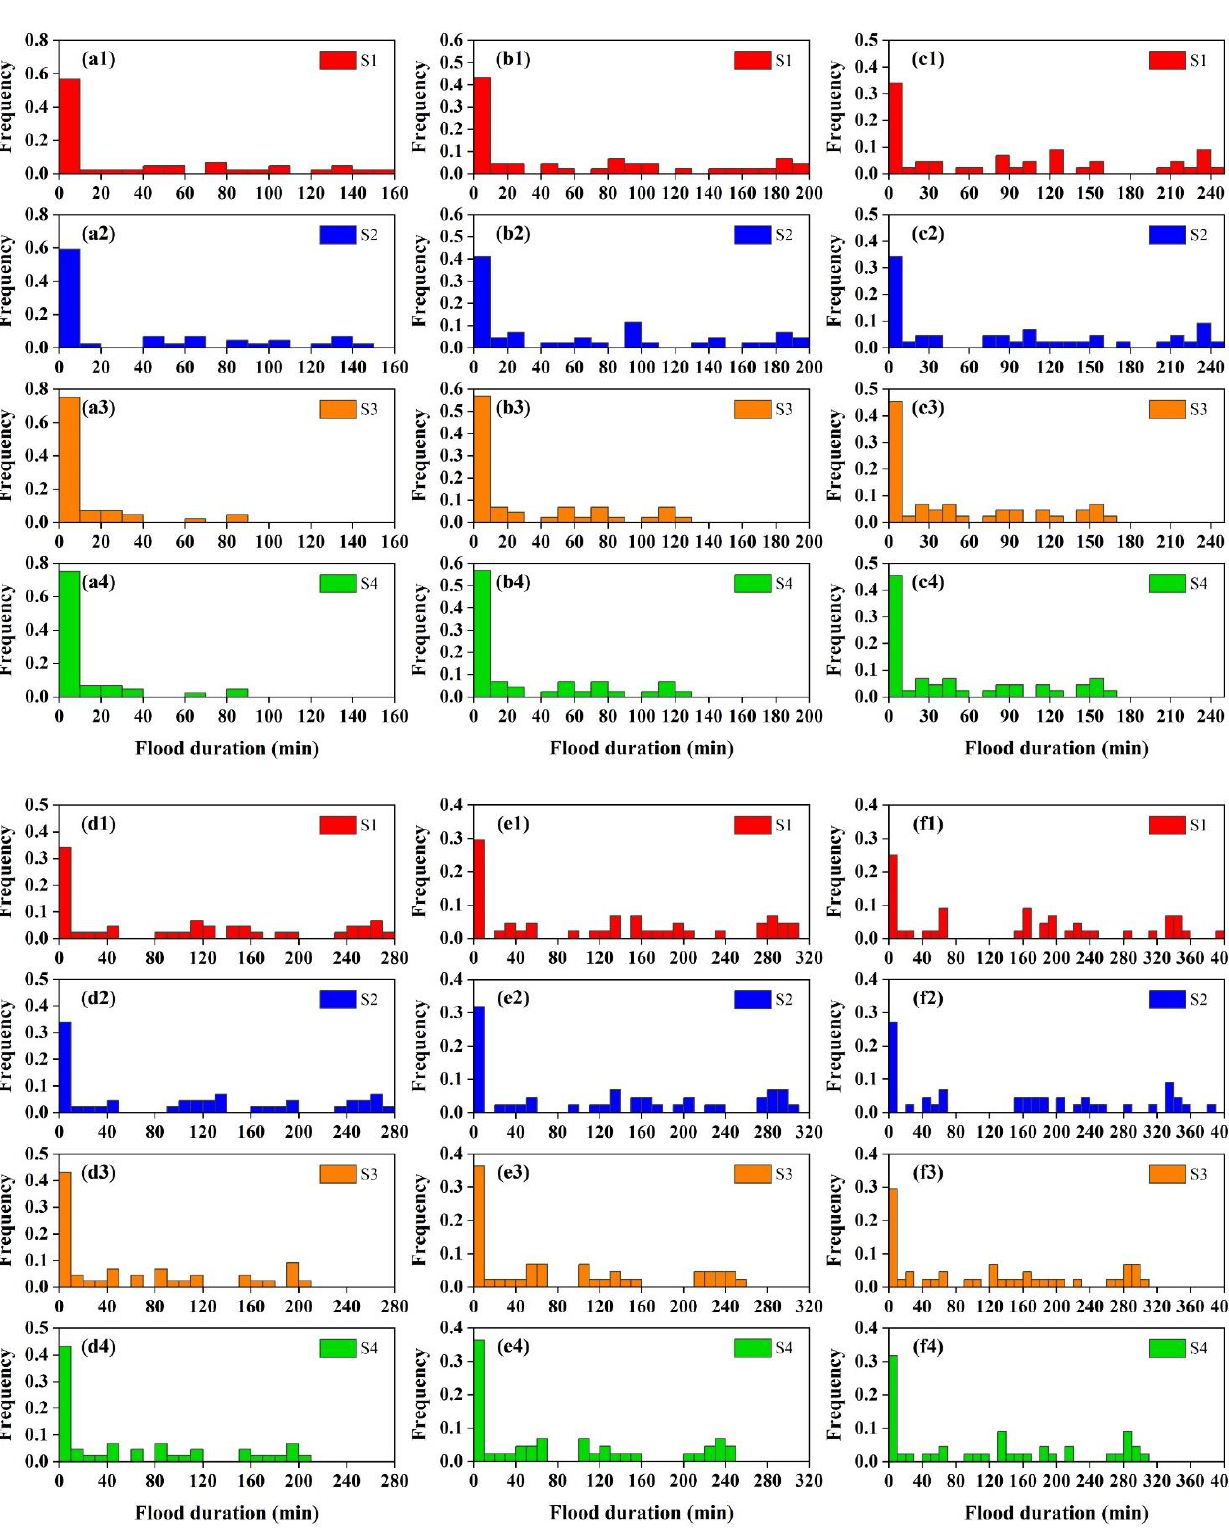
Figure 5. Frequency distribution of overflow cumulative duration of junction nodes for the various scenarios (S1, S2, S3 and S4) and rainfall events with return period of ( a1 – a4 ) 5, ( b1 – b4 ) 10, ( c1 – c4 ) 20, ( d1 – d4 ) 30, ( e1 – e4 ) 50, and ( f1 – f4 ) 100 years.